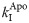
Logistic apoptosis rate enables reproduction of cell population dynamics.Model fits to cell population measurements from MDCK cell cultures infected with influenza A/PR/8/34 (H1N1) at an MOI of 73 [4]. Mean percentage values of (A) infected, non-apoptotic and (B) infected, apoptotic cells from three independent experiments are shown. Curves represent simulations of the original [24] (dashed) and the extended (solid) multiscale model. (C) Comparison of infected, non-apoptotic cell apoptosis rate dynamics using a stepwise (original model, [24]) and logistically (extended model) increasing virus-induced apoptosis rate kIApo. Hours post infection in (A) and (B) refer to the time passed since the cell culture was infected while in (C) it corresponds to the individual infection time point of a cell.